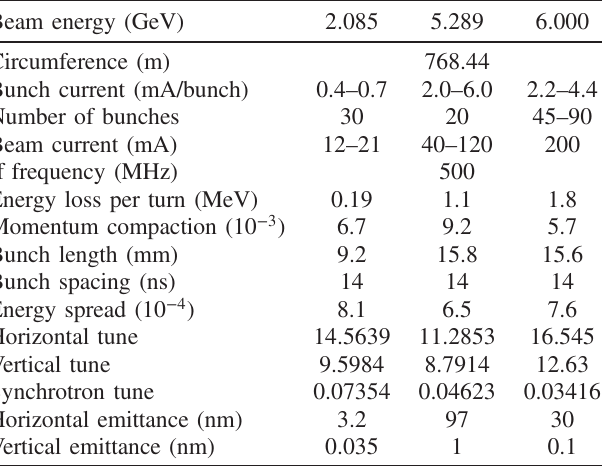
rations of the CESR ring addressed in this report: the 2.1 and 6.0 GeV configuration for which the model was used to assess effects of electron cloud buildup on